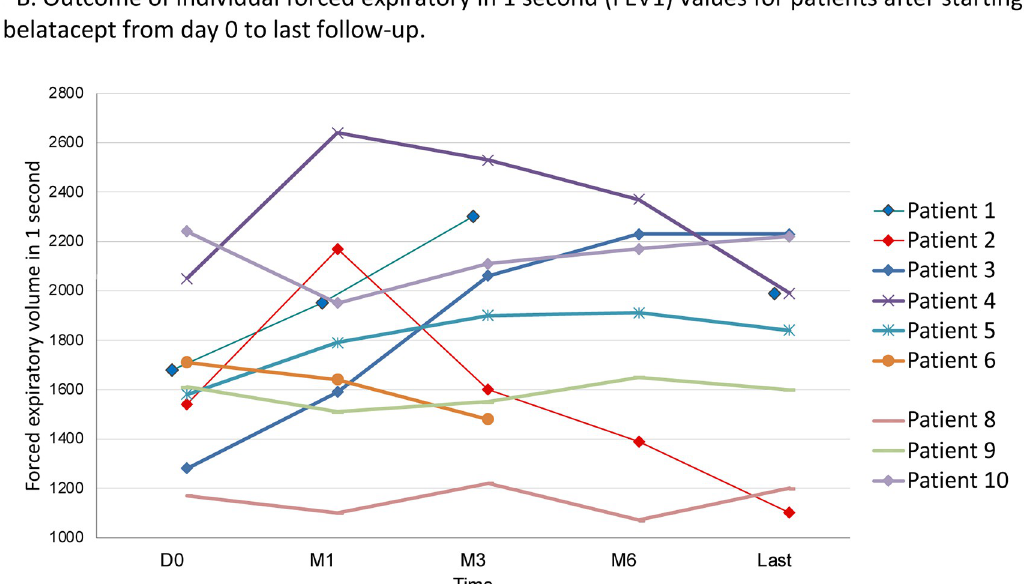
Fig 2. A: Outcome of individual serum creatinine clearance values in the 10 patients after starting belatacept, from day 0 of belatacept to last follow-up under belatacept; B: Outcome of individual forced expiratory in 1 second (FEV1) values for patients after starting belatacept from day 0 to last